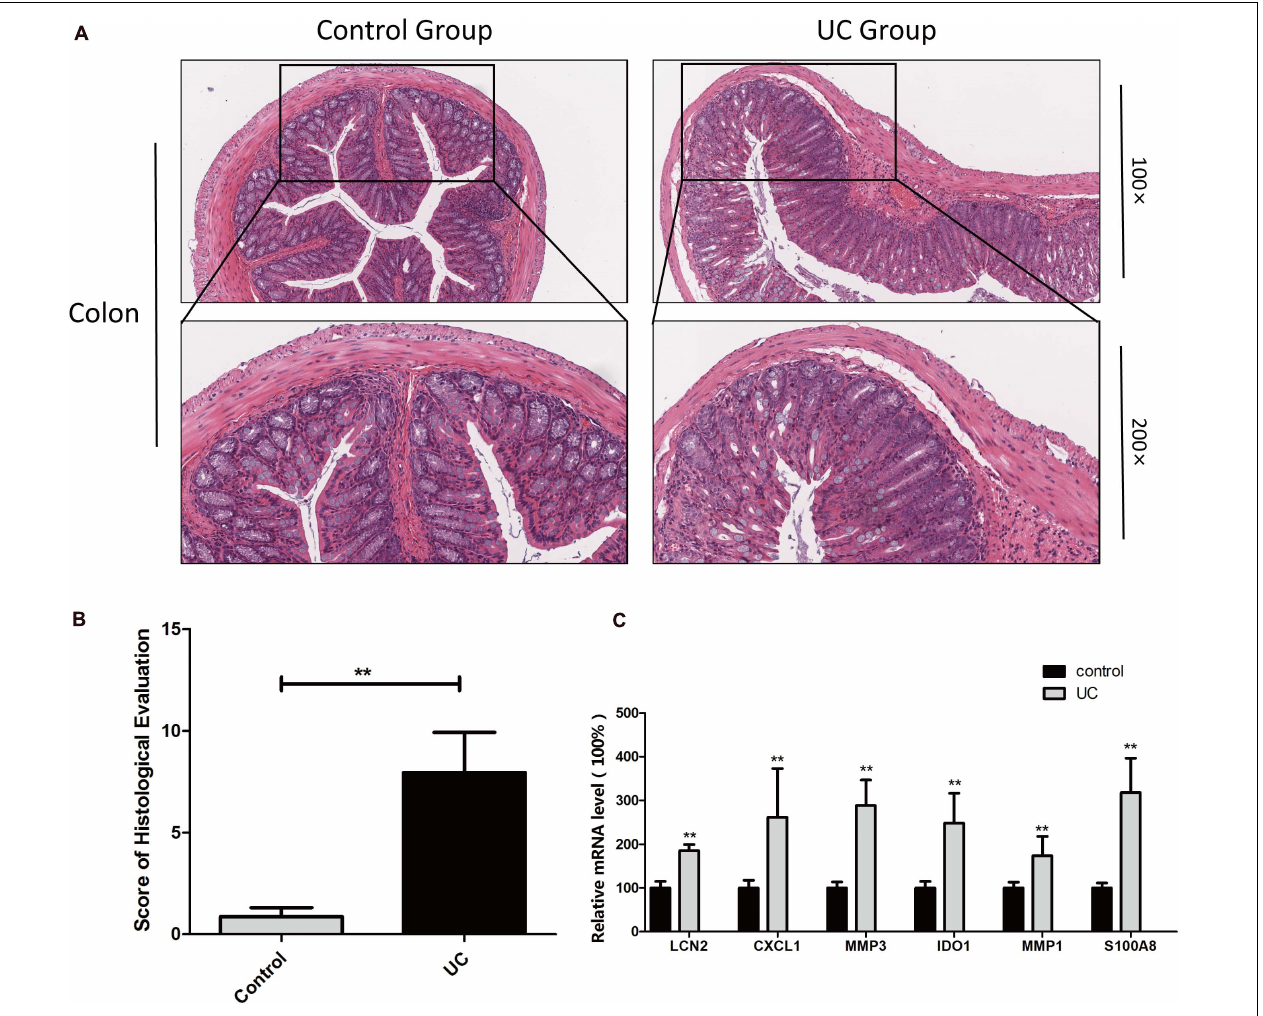
FIGURE 10 | Determination of hub genes in mouse UC model H&E staining of colon tissues from the control and dextran sulfate sodium-induced colitis model mice (A) and histological lesion score of colon tissues (B) were performed. The expression of hub genes was examined by qPCR, and β -actin served as an internal reference (C) . **Indicates p <